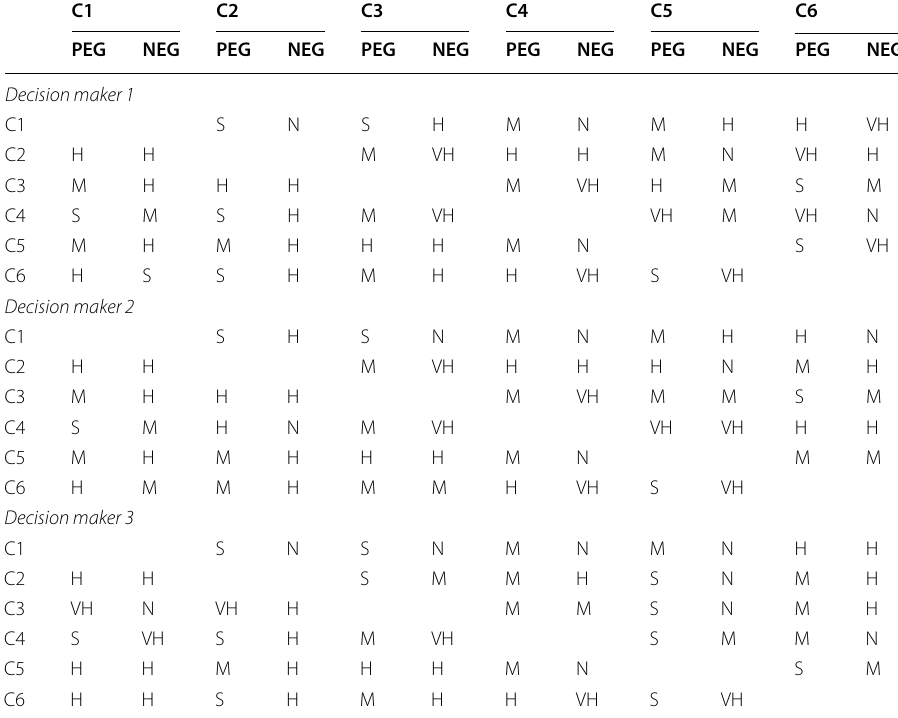
Table 11 Linguistic evaluations for